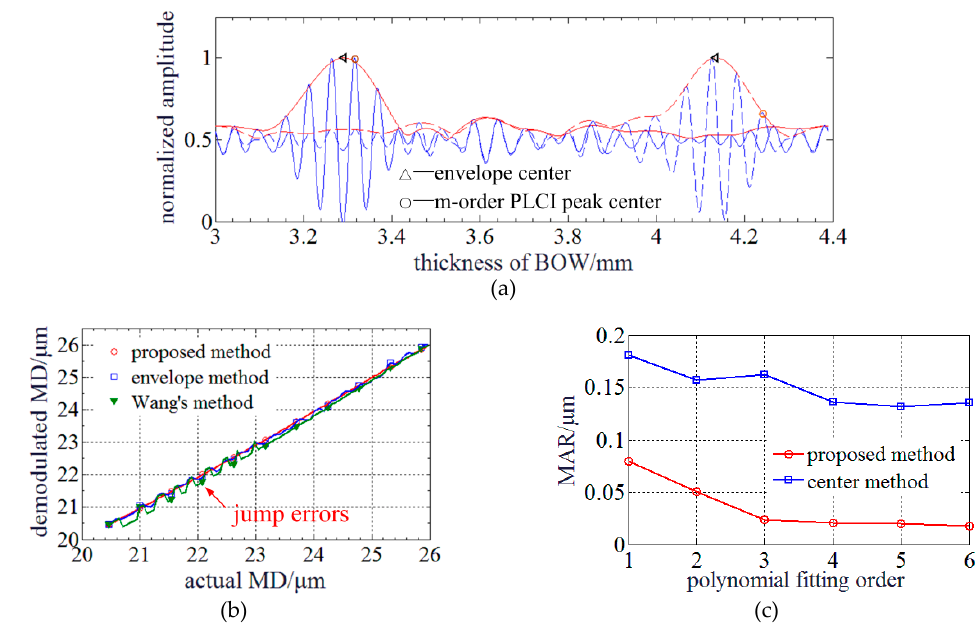
Figure 9. Experimental results of PLCIF and polynomial fittings: ( a ) PLCIF results when MDs are 20.4 μ m and 26.0 μ m: The blue and red lines represent the measured PLCIFs achieved by SC and envelopes curves achieved by FFT method; ( b ) Relationship between the demodulated and actual MDs; ( c ) MARs of different polynomial fitting orders.